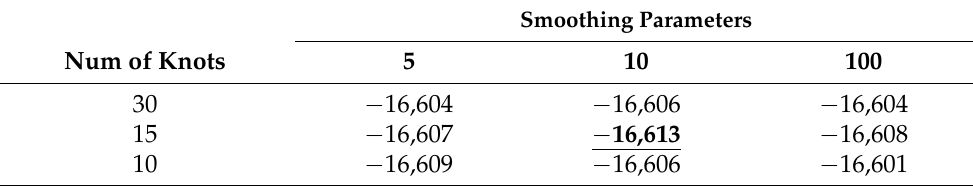
The best of each distribution is underlined, and the best overall is in bold. Table 24. DIC for Weibull distribution (27 July 2016, JAL, Tokyo, Japan). Smoothing Parameter